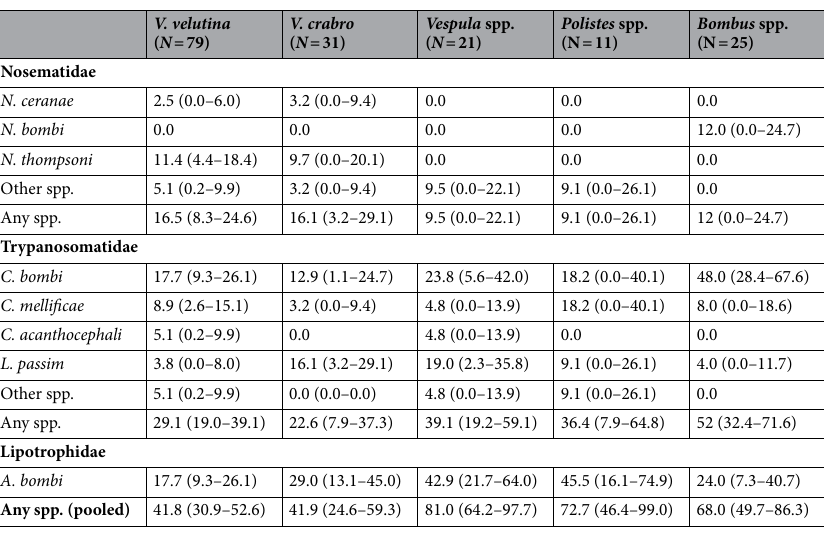
Table 1. Parasite prevalence across hosts. Relative frequencies (in %) and 95% CI. Any spp. refers to the pooled fraction of samples with at least one parasite species. These values are usually smaller than the sum of the frequencies of each species because some samples harbour more than one